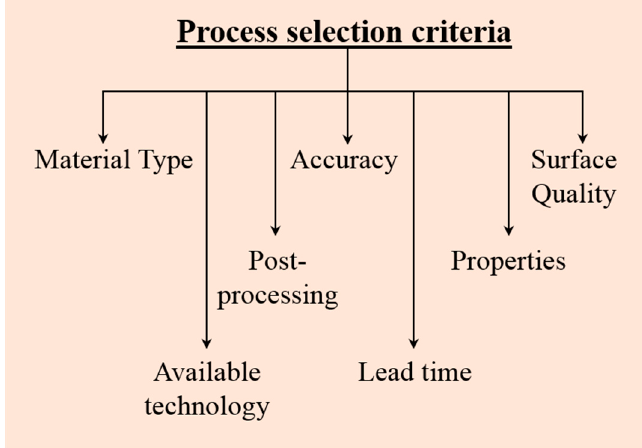
Figure 1. Schematic illustration showing the different factors that should be considered in selecting the right additive manufacturing process (binder jetting, selective laser melting, or electron beam melting).